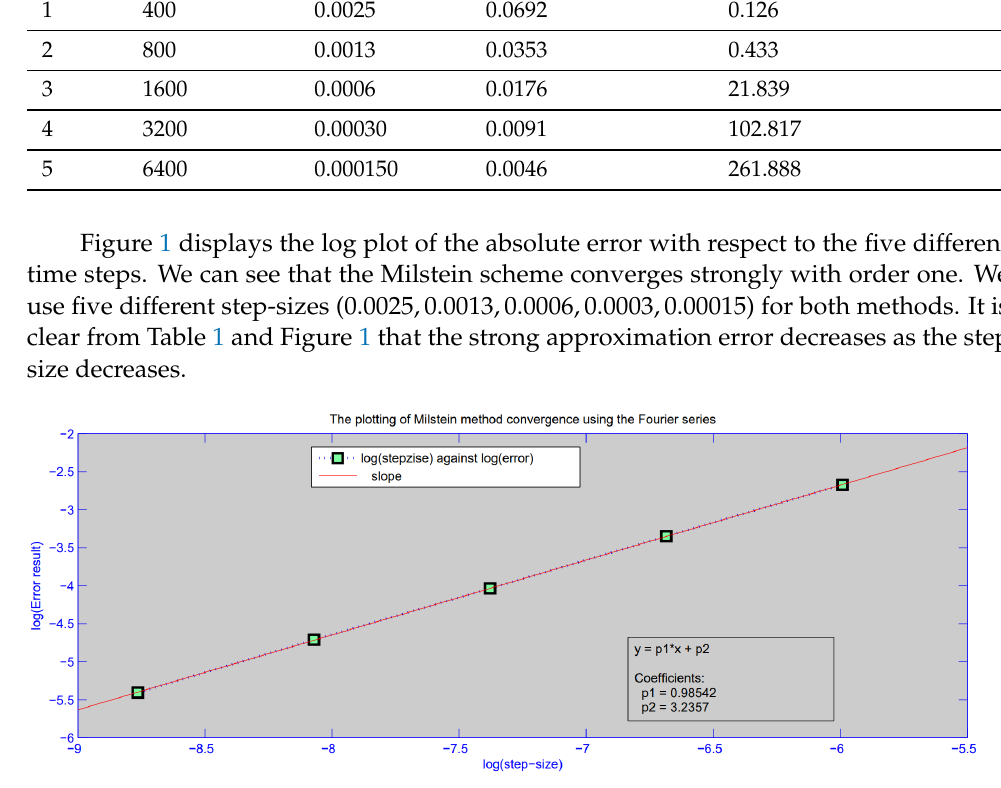
Figure 1. Plot of the Milstein